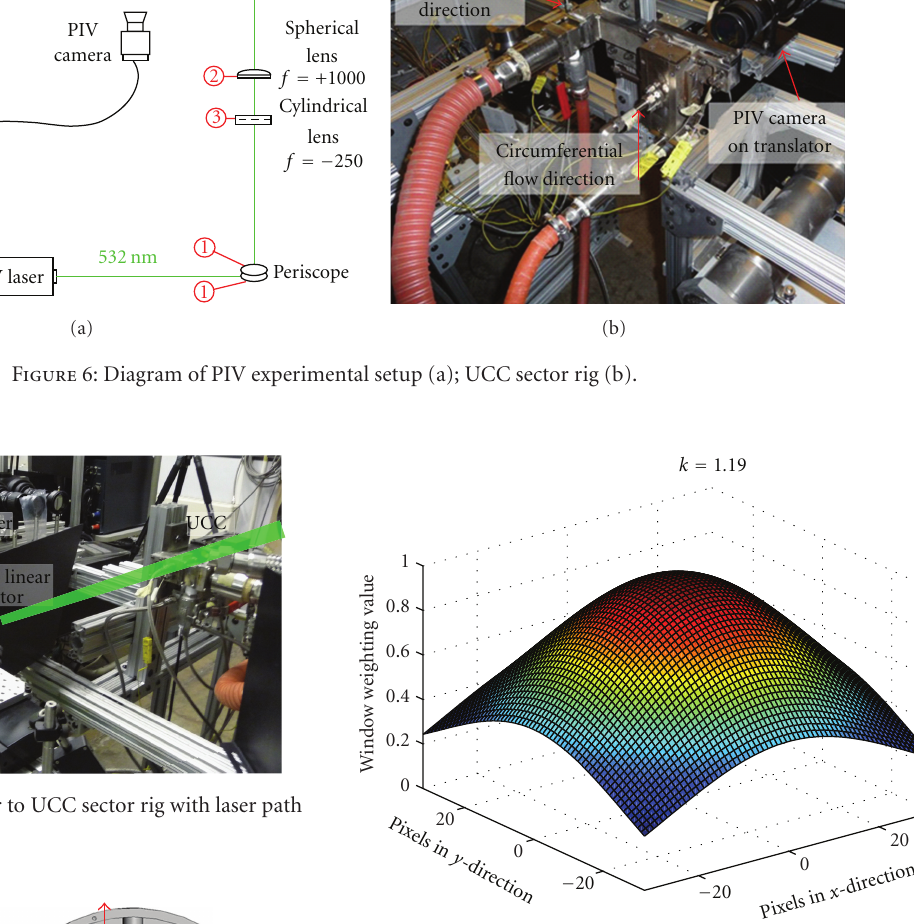
Figure 9: Weighting coe ffi cients used with window function.